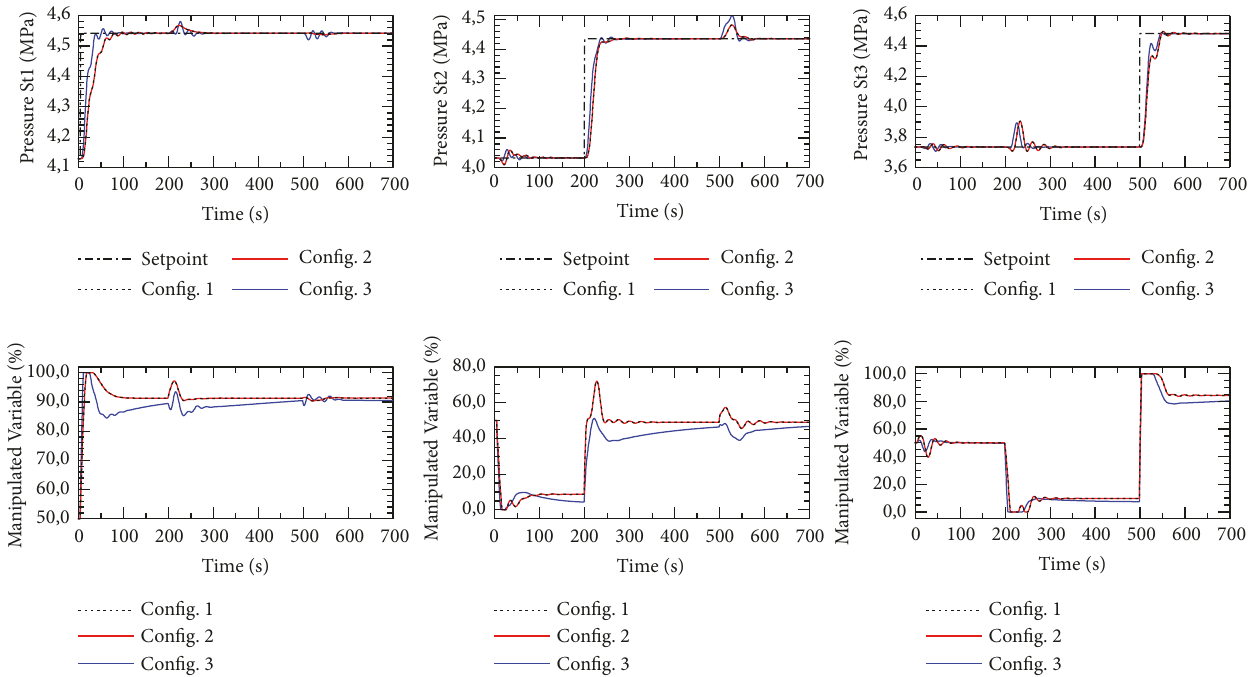
Figure 8: Pressure Response, under setpoint changes, for Configurations 1, 2, and